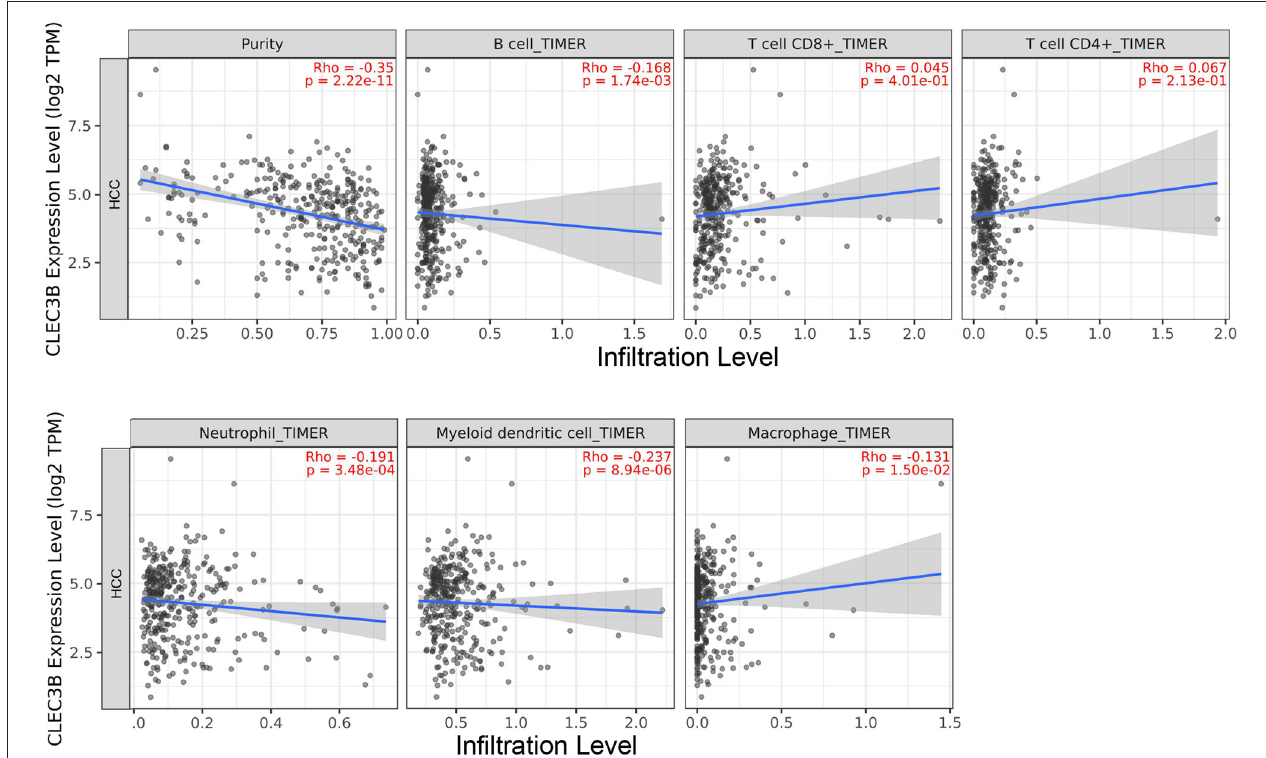
FIGURE 3 | Correlation analysis between CLEC3B expression and immune cell infiltration levels in HCC via TIMER analysis ( n = 371).